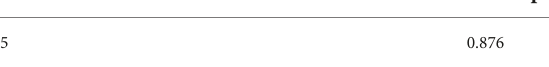
TABLE 1 Reliability statistics.